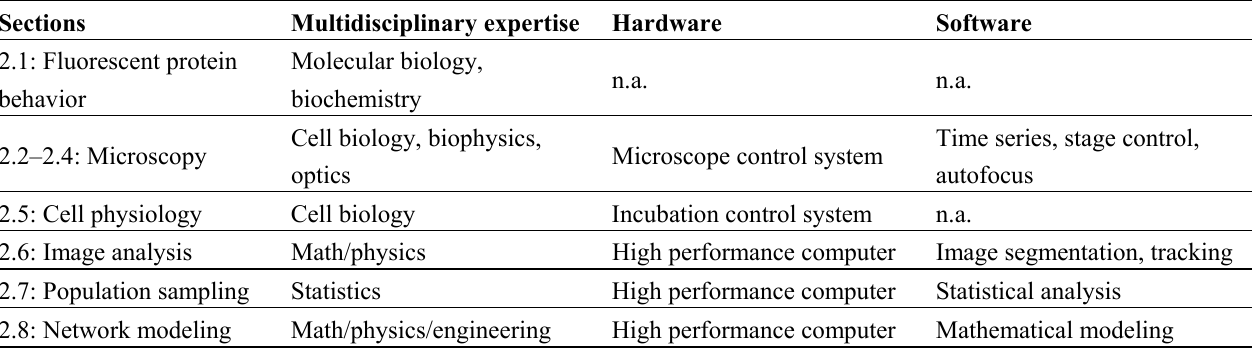
Table 1. Necessary skills and resources required for quantitative live cell imaging.